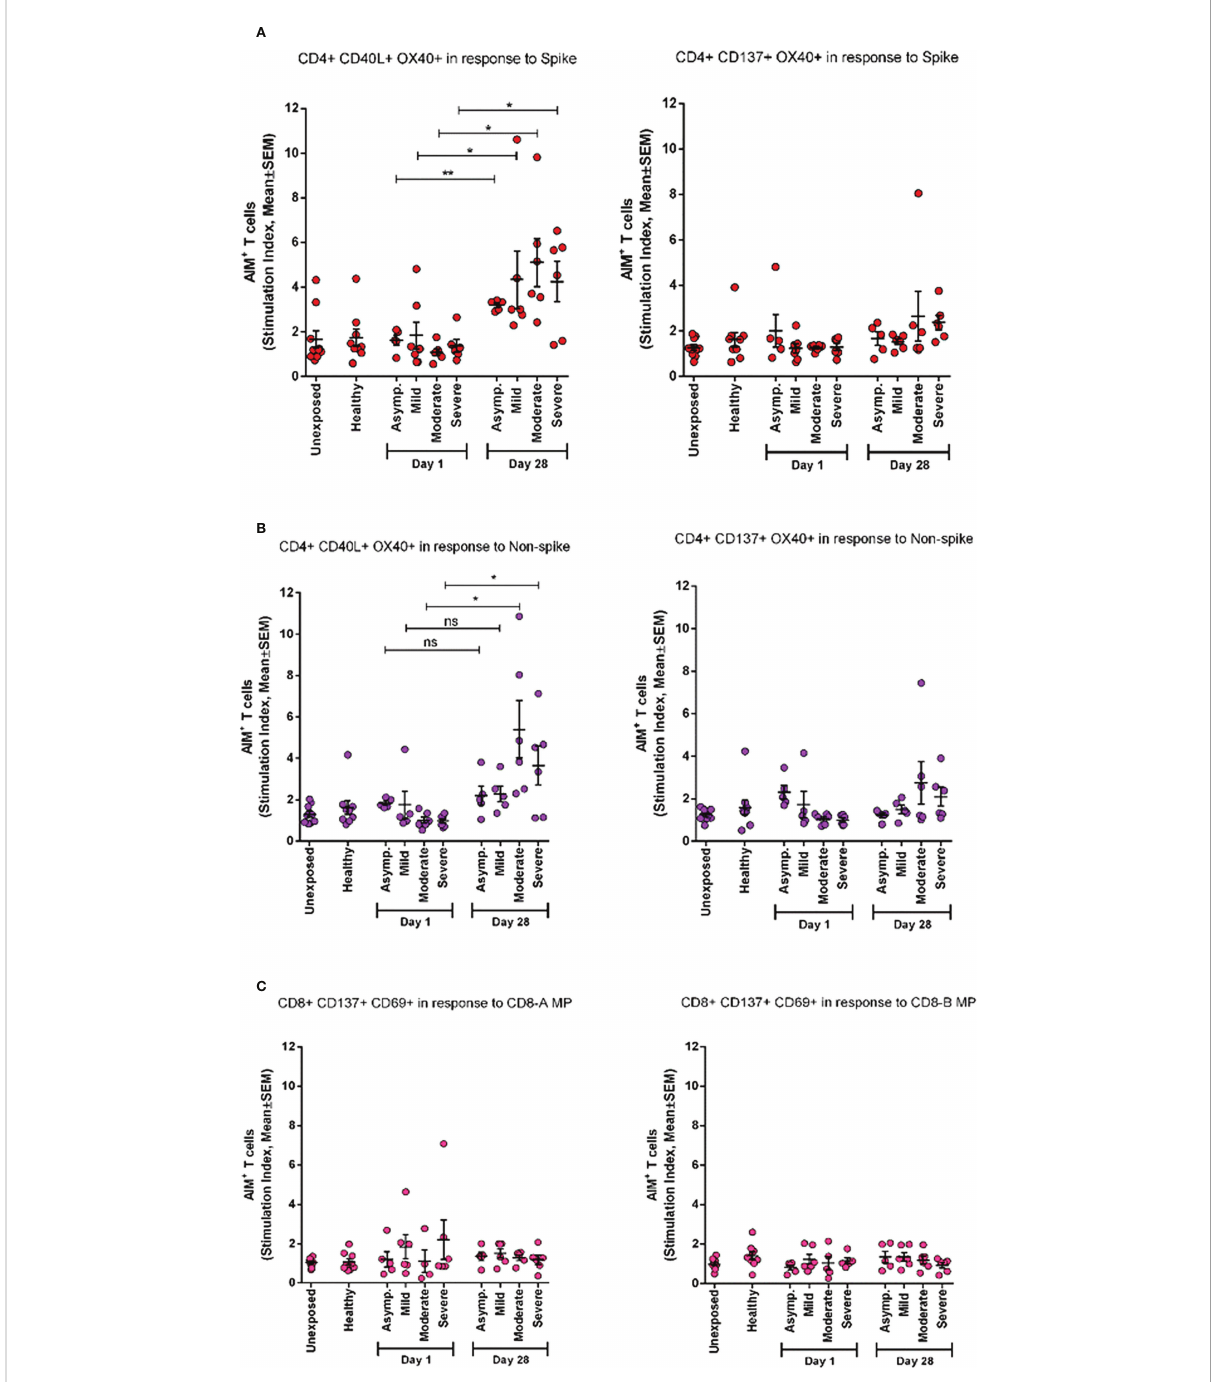
FIGURE 5 AIM expression in different categories of COVID-19 patients (asymptomatic (n=5), mild (n=5), moderate (n=6), and Severe (n=6)) immediately after infection (Day1) and after one month of infection (Day 28) and compared with both unexposed (n=10) and healthy (n=9) controls. (A) Stimulation of AIM+ (OX40+ CD40L+ and OX40+ CD137+) CD4+ T cells in response to Spike antigen; (B) Stimulation of AIM+ (OX40+ CD40L+ and OX40+ CD137+) CD4+ T cells in response to non-spike megapool peptides; (C) Stimulation of AIM+ (CD137+ CD69+) CD8+ T cells